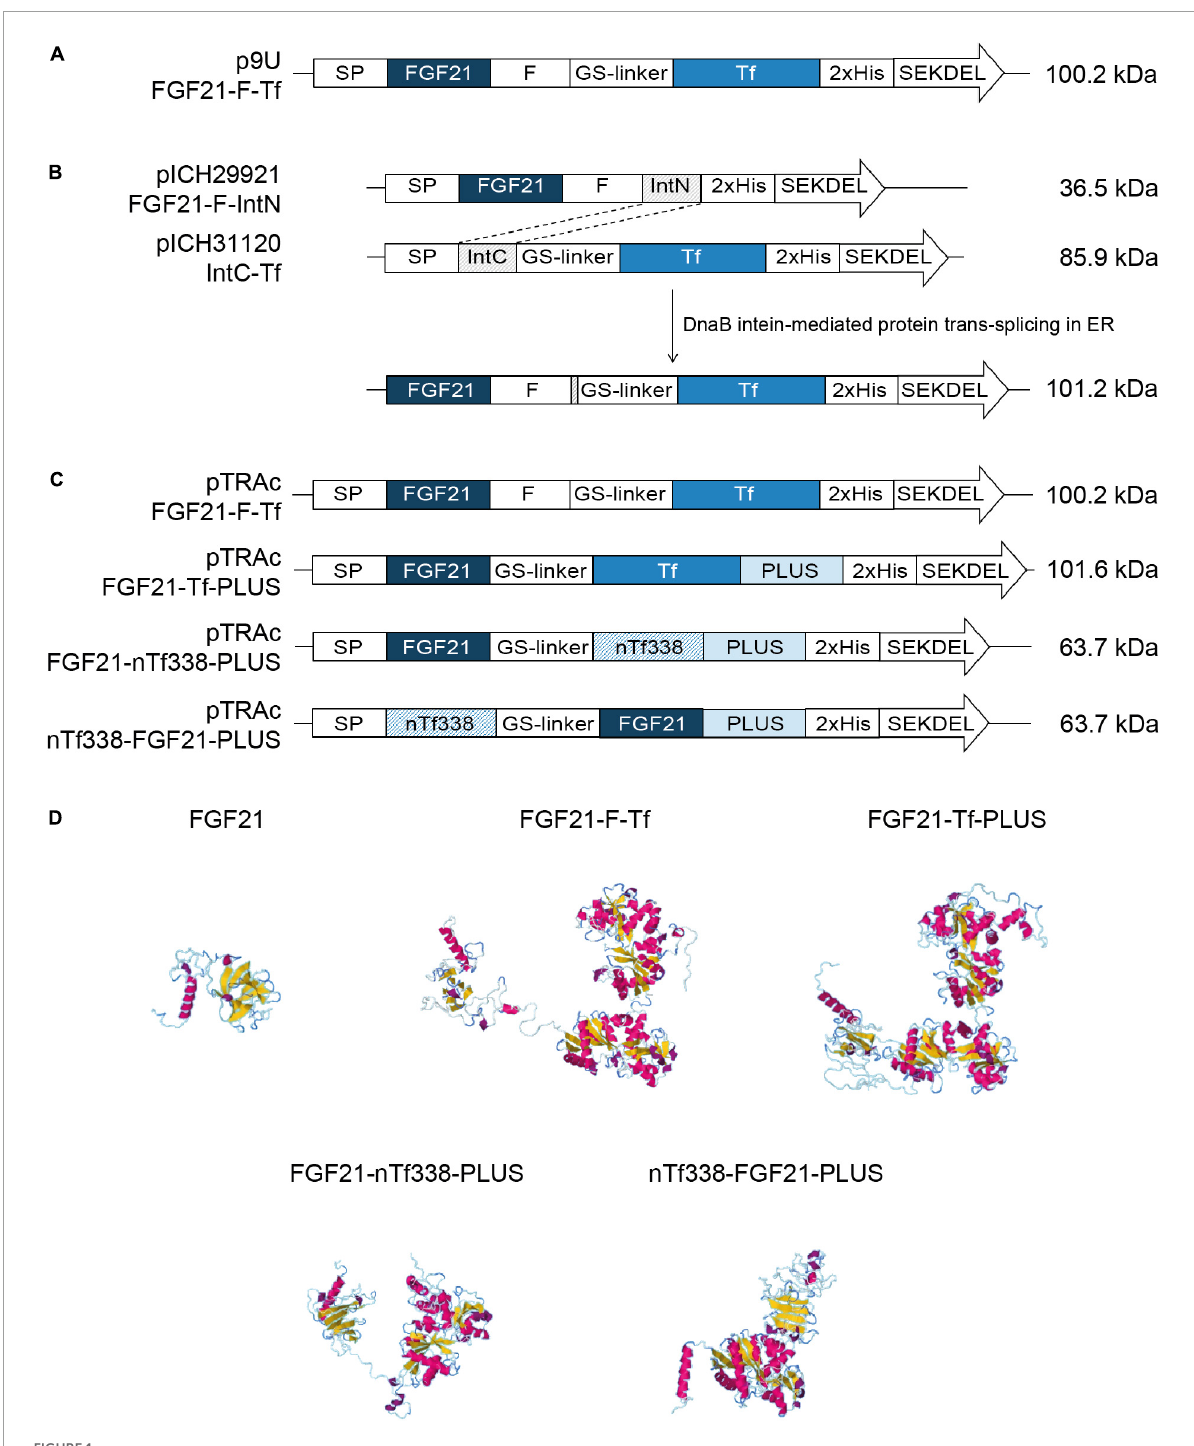
FIGURE1 Constructs and models used for the stable and transient expression of FGF21-transferrin fusion proteins. (A) p9U stable expression vector containing FGF21-F-Tf in N. tabacum SL632 and VG. (B) MagnICON transient expression vectors pICH29921 and pICH31120 containing FGF21-F-IntN and IntC-Tf and (C) pTRAc transient expression vectors containing FGF21-F-Tf, FGF21-Tf-PLUS, FGF21-nTf338-PLUS, and nTf338-FGF21-PLUS in N. benthamiana . (D) The three-dimensional structures of different FGF21-Tf fusion proteins predicted by submitting the amino acid sequence to the RaptorX software (http://raptorx.uchicago.edu/). SP, signal peptide; F, furin cleavage site, RRKRSV; GS linker, flexible linker, (GGGGS) 3 ; 2xHis, double-His 6 tag; SEKDEL, ER-retention signal; IntN and IntC, DnaB intein fragments; PLUS, liver-targeting peptide circumsporozoite protein (CSP), aa 82–100; nTf338, N-terminal domain of Tf, aa